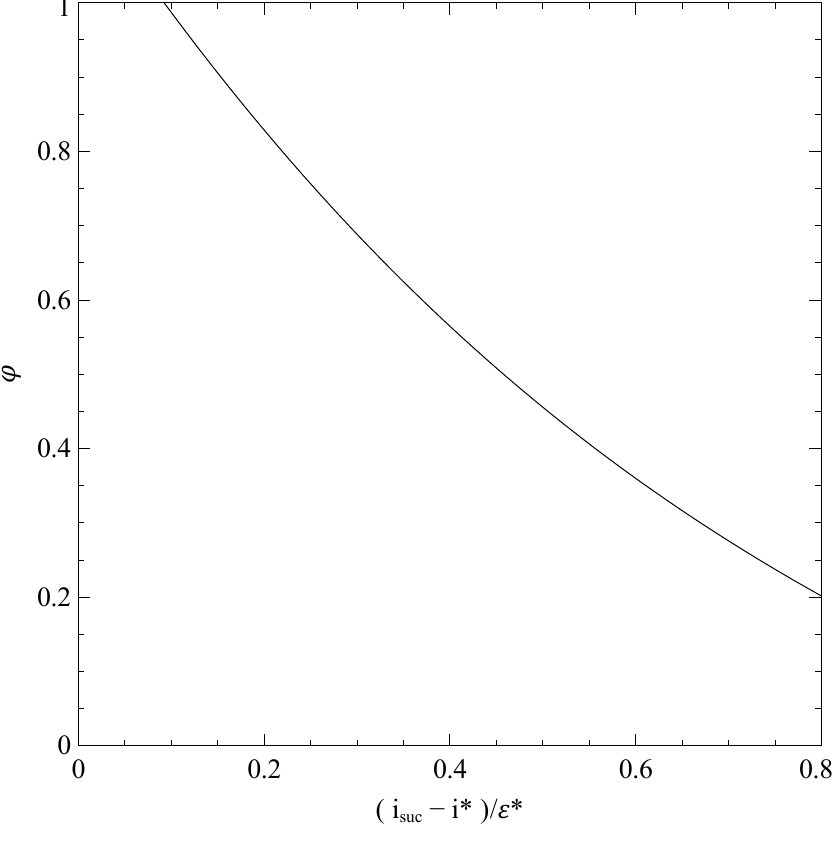
Figure 15. Computed flow coefficient for each incidence